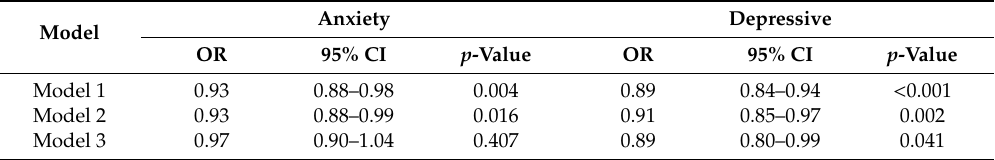
Associations between the daily intake of vitamin B6 (10 µ g / MJ) and anxiety and depressive